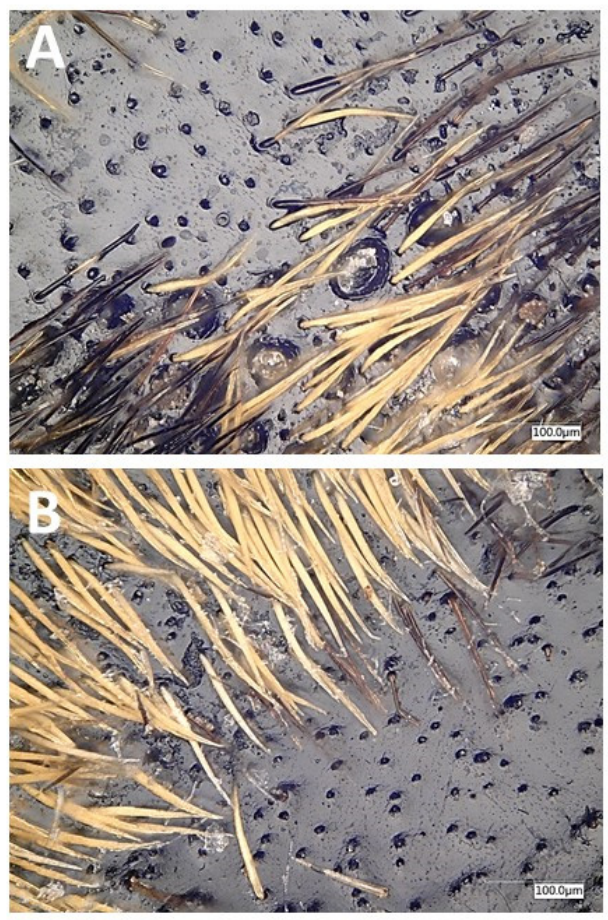
Figure 1. Dorsal surface of the prothoraces of male ( A ) and female ( B ) Plagionotus detritus . The oval-shaped pores found in males were absent in females (magnification 500 × ).